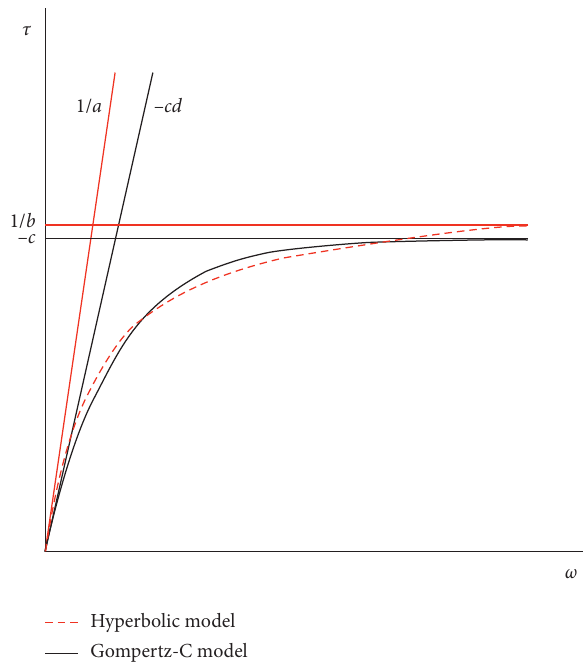
Figure 10: Schematic diagram of the interface model. Table 4: Parameters of the interface mathematical